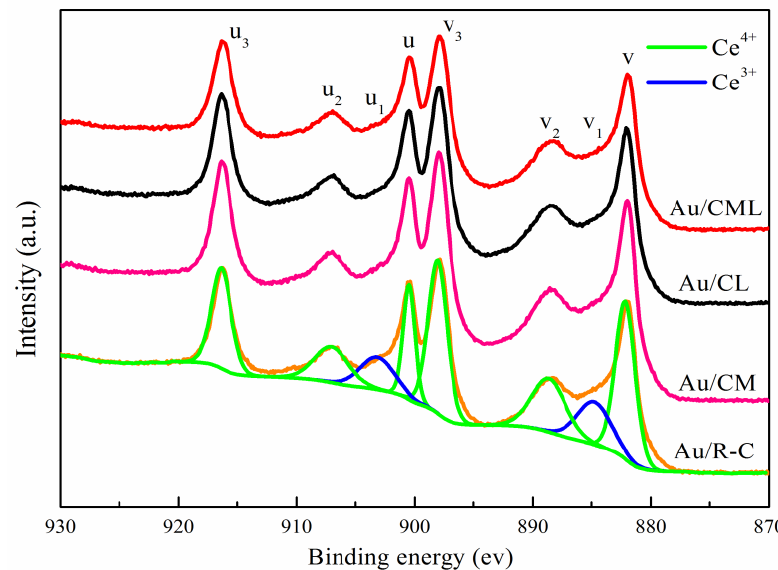
Figure 5. XPS spectra of Ce 3d .